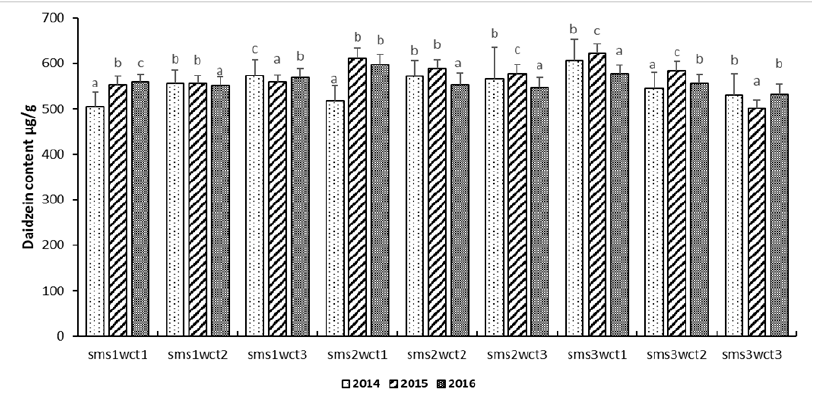
Figure A3. Daidzein concentration in soybeans influenced by field year. Sms: soil tillage system and wct: weed control treatment. The values shown are means ± S.E. Different lowercase letters above the bars indicate significant differences in daidzein concentration between the years undergoing the same treatment, according to Tukey’s HSD test ( P ≤ 0.05). Land 2020 , 9 , x FOR PEER REVIEW